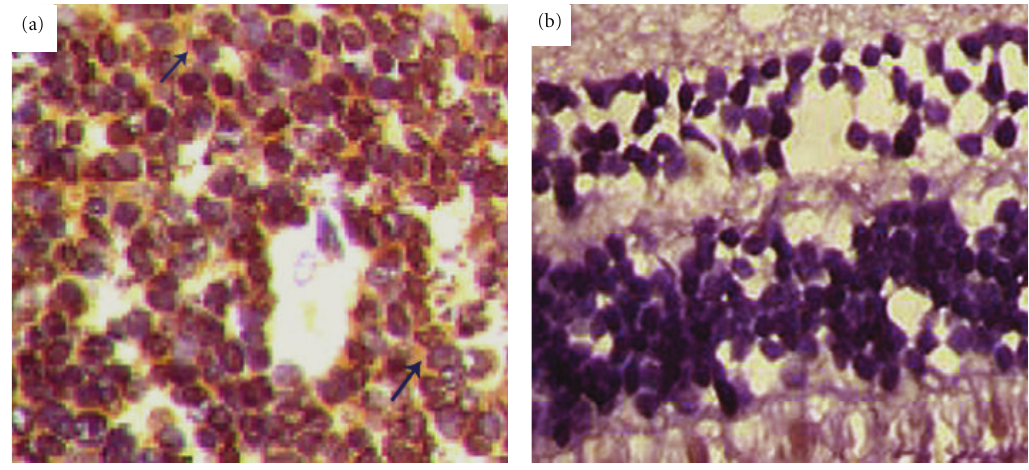
Figure 1: Immunohistochemical staining for CD24 in human retinoblastoma tissues (original magnification × 200). (a) CD24 staining is negative in non-neoplastic retina; (b) CD24-positive expression was found in the cytoplasm of retinoblastoma tissues.